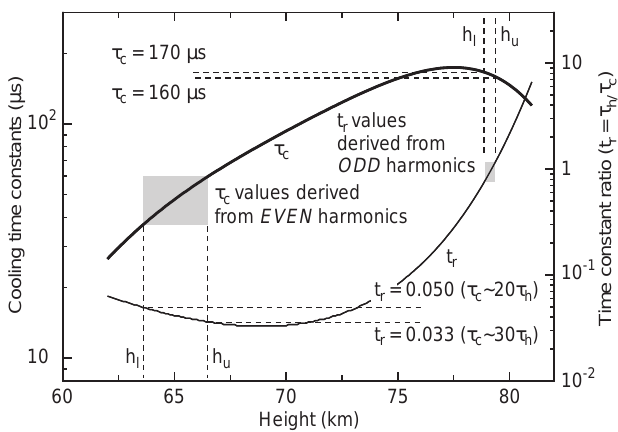
Fig. 15. Cooling time constants and time constant ratios plotted as a function of height in the ionosphere (derived from Rietveld et